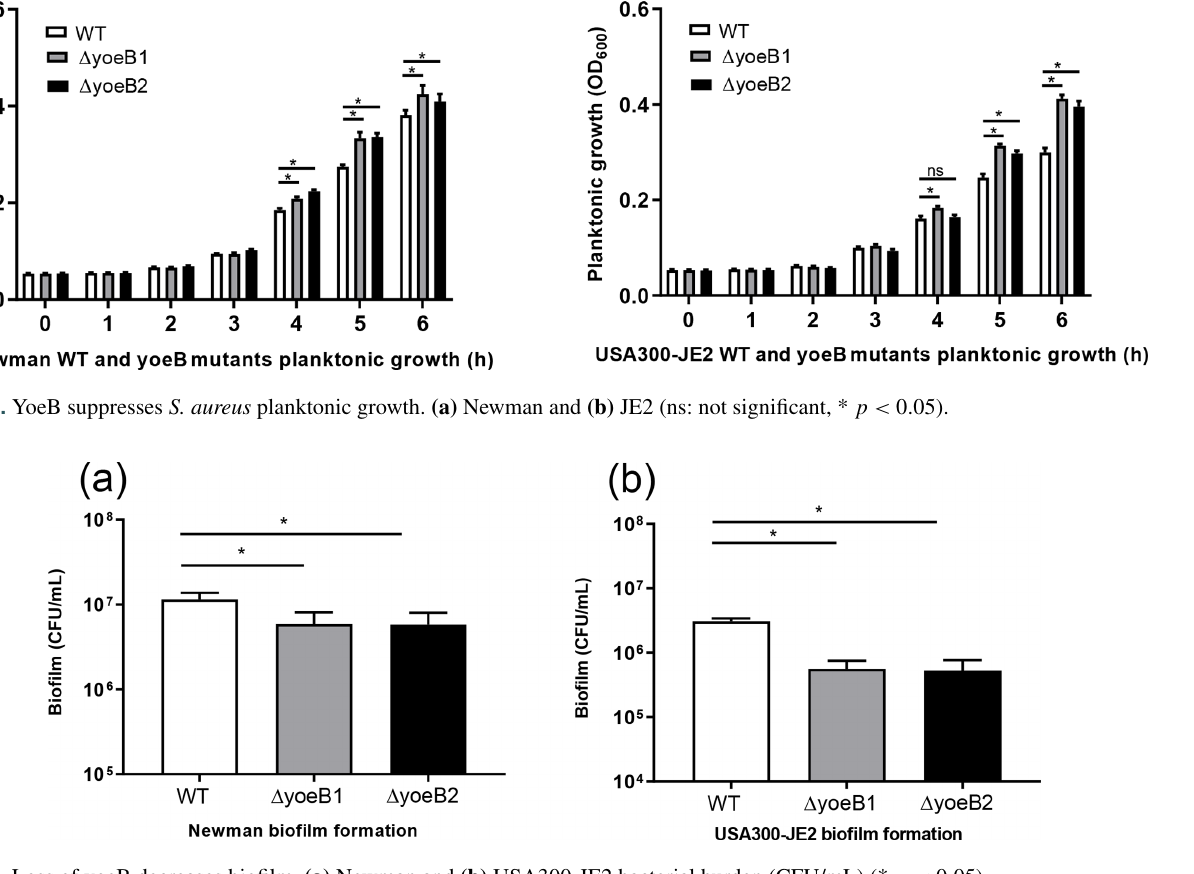
Figure 2. Loss of yoeB decreases biofilm. (a) Newman and (b) USA300-JE2 bacterial burden (CFU/mL) (* p < 0 .